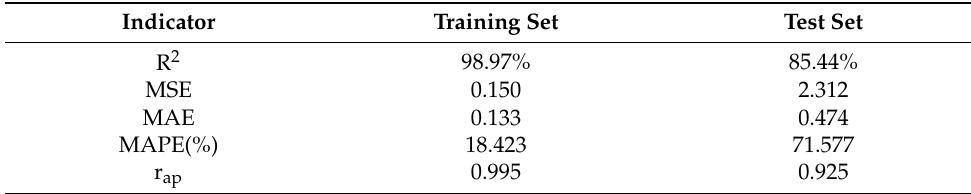
Table 1. Indicators of the GRNN model’s quality. Indicator Training